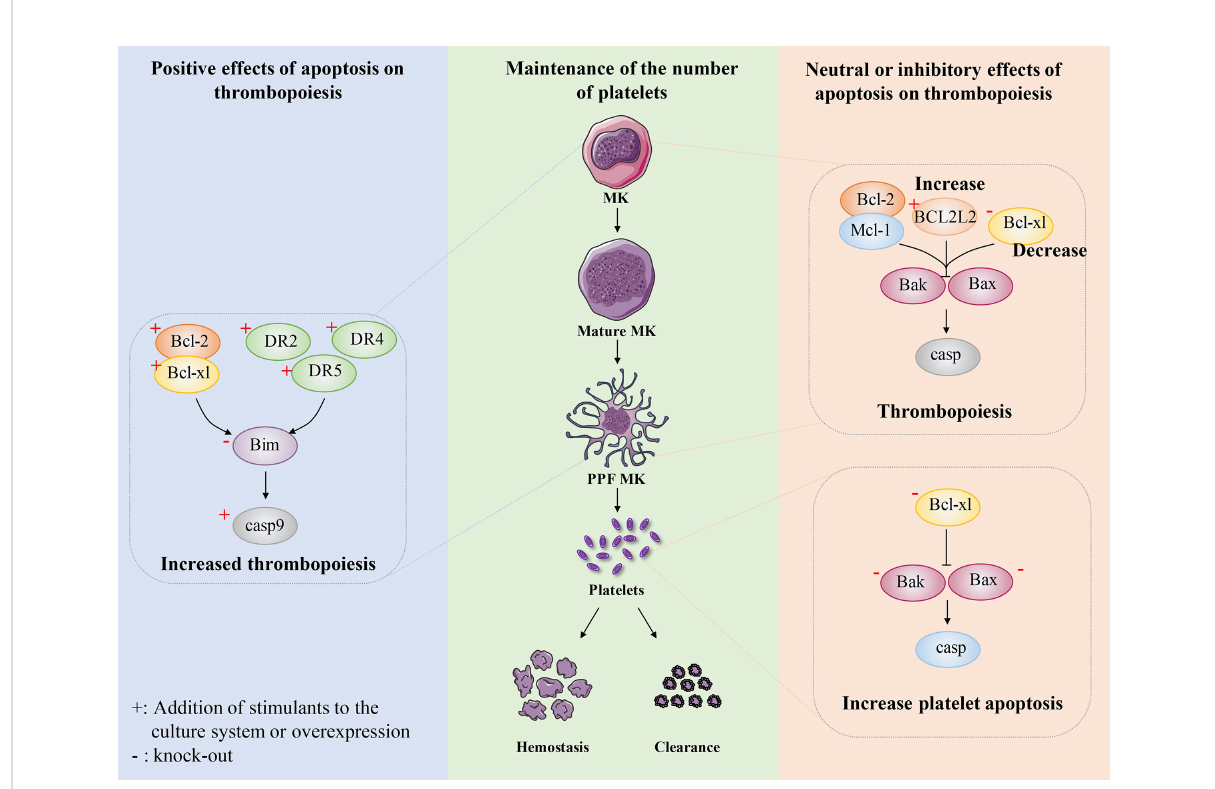
FIGURE 4 The role of apoptosis in megakaryocyte and platelet biology. Maintaining the number of platelets in a dynamic balance range is very important for normal hemostasis, coagulation and immune function. The number of circulating platelets is closely related to the lineage development of MKs, platelet production and platelet apoptosis. Some researchers believe that platelet production depends on apoptosis. After expressing human anti-apoptotic protein Bcl-2 in mice, or overexpressing anti-apoptotic protein Bcl-xl in mice, or knocking out pro-apoptotic protein Bim in mice, intrinsic apoptosis was inhibited to some extent and the number of platelets decreased. In addition, exogenous stimulation DR2, DR4, DR5, the apoptosis pathway is activated to some extent, which shows the increase of circulating platelets. These results indicate that platelet production depends on apoptosis. Recently, researchers have conducted a relatively systematic study on the development of platelet number- related MK lineage, platelet production and platelet apoptosis. They believe that platelet production does not depend on apoptosis and endogenous apoptosis should be inhibited. The absence of Bcl-2 and Mcl-1 had no effect on platelet count. Overexpression of BCL2L2 inhibits apoptosis to a certain extent, resulting in the failure of PPF. The absence of Bcl-xl results in severe thrombocytopenia, which not only promotes platelet apoptosis and shortens platelet life, but also seriously damages platelet production. Bax/Bak have little effect on platelet production, but after deletion, it results in prolonged platelet life and relative increase in peripheral platelet number. These fi ndings indicate that platelet production do not depend on apoptosis and intrinsic apoptosis should be